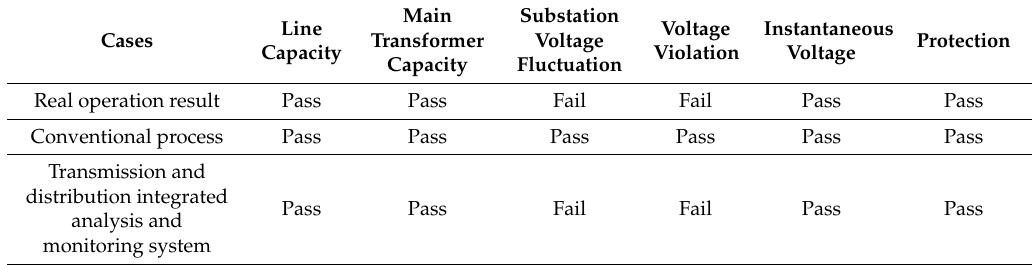
Table 6. Results of a preliminary evaluation of the DG connection and real